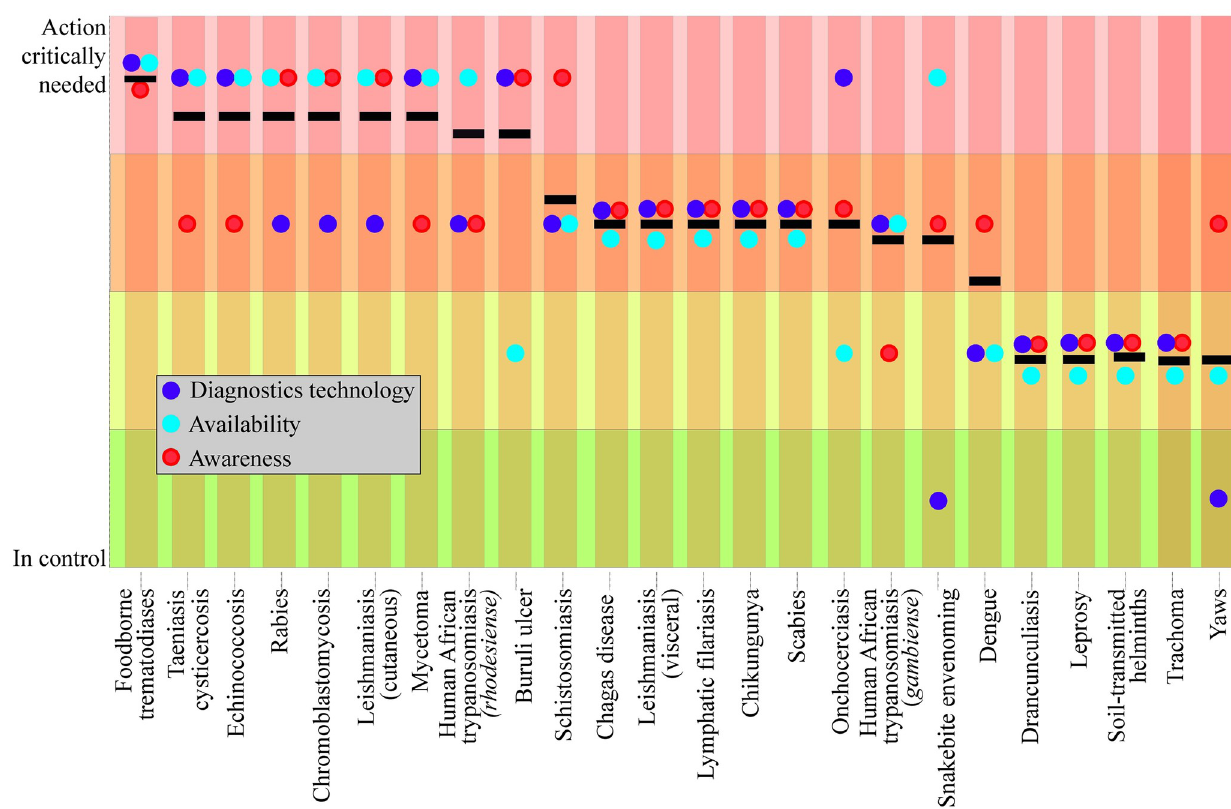
Fig 4. Diagnostic insufficiencies for NTDs. NTDs were ranked in the order of diagnostic insufficiencies (black bars) as deduced from 3 parameters: diagnostics technology (purple), availability (blue), and awareness (red), and scored for “action critically needed” to “in control.” Information was obtained from a literature survey, including comprehensive recent reports from WHO, particularly WHO 2021–2030 roadmap [8] and the diagnostic technical advisory group for NTDs report [20]. Data were critically analyzed to gather diagnostic insufficiencies for individual diseases. NTD, neglected tropical disease; WHO, World Health